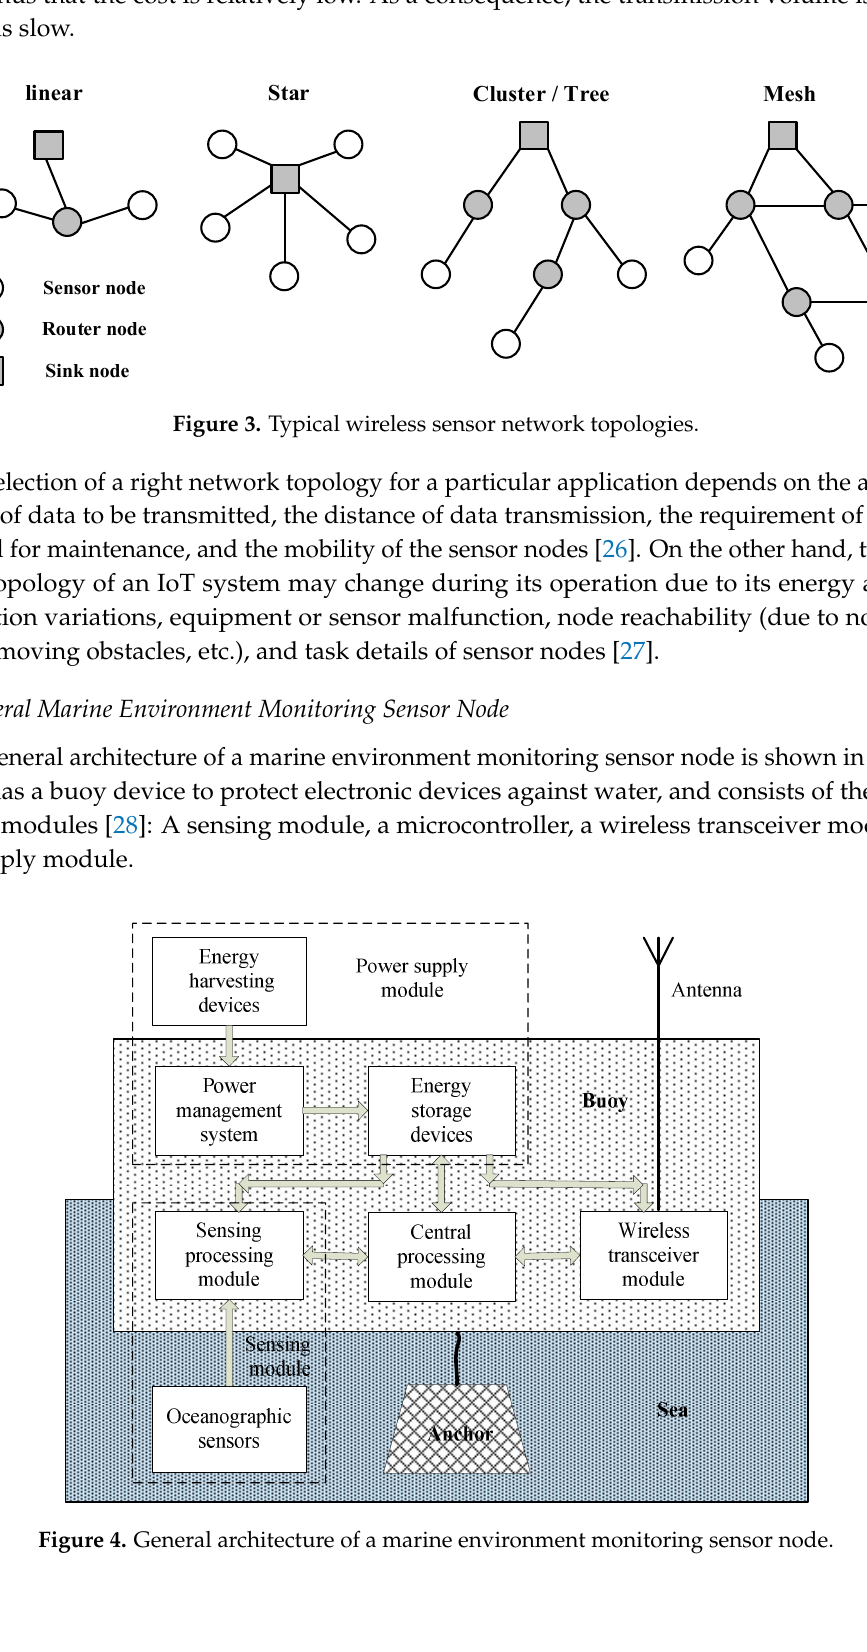
Figure 3. Typical wireless sensor network